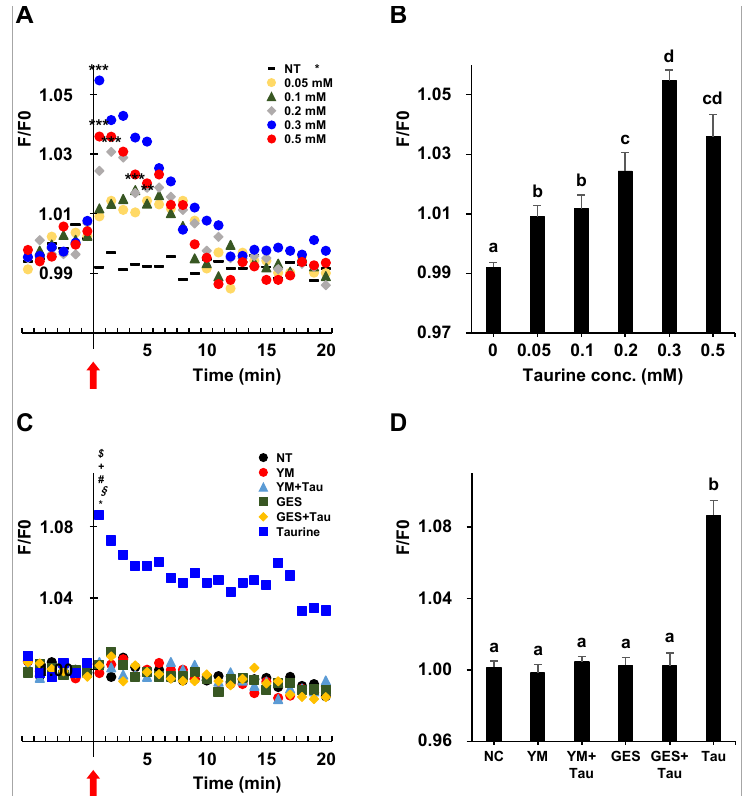
Figure 8. Taurine induces [Ca 2+ ]i influx in L6 myotubes. ( A ) Changes in the [Ca 2+ ]i influx were measured in response to 0.05–0.5 mM taurine treatment in L6 cells. Arrow indicates the addition of taurine. NT: non-treatment condition. The data are the average values of 3–12 independent experiments. Results were analyzed using one-way ANOVA followed by Tukey’s test for multiple comparisons. Statistical differences are shown as ** p < 0.05, *** p < 0.001, compared to NT. ( B ) Peaks of average values were analyzed using one-way ANOVA followed by Tukey’s test for multiple comparisons. Values with different superscript lowercase letters indicate significant differences ( p < 0.05). ( C ) Changes in [Ca 2+ ]i influx were measured in response to 0.3 mM taurine in L6 cells treated or not treated with YM-254890 (YM, 1.0 µ M) or GES (0.3 mM) for 24 h. Arrow indicates the addition of taurine. NT: non-treatment condition. The data are the average values of 3–12 independent experiments. The results were analyzed using one-way ANOVA followed by Tukey’s test for multiple comparisons. Statistical differences are shown as * p < 0.001, compared with NT. § p < 0.001, compared with YM. # p < 0.001, compared with YM + taurine. + p < 0.001, compared with GES. $ p < 0.001, compared with GES + taurine. ( D ) Peaks of average values were analyzed using one-way ANOVA, followed by Tukey’s test for multiple comparisons. Values with different superscript lowercase letters indicate significant differences ( p <